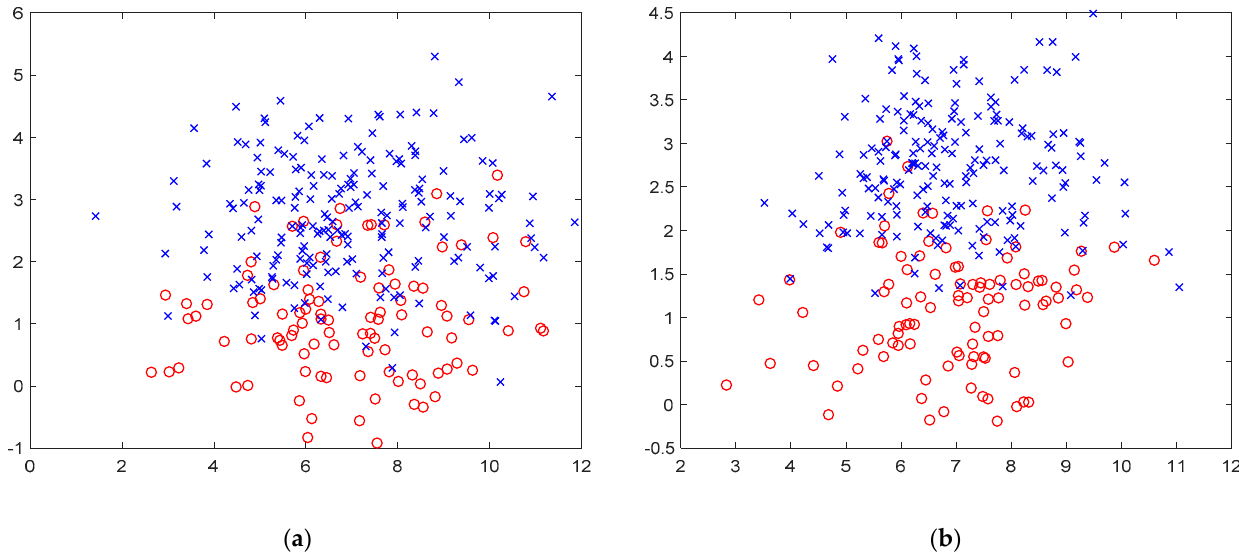
Figure 3. ( a ) Scatter plot of unprocessed data. ( b )Scatter plot of sliding window wavelet denoising processing data.